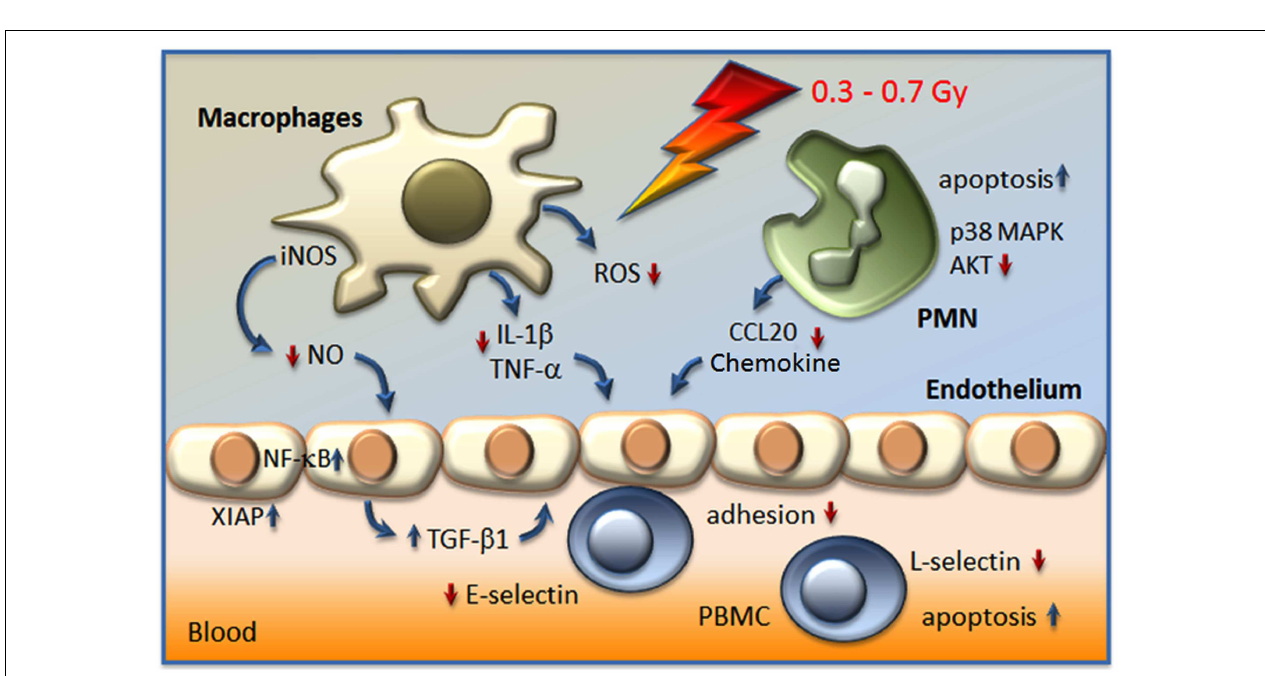
synthase (iNOS) in line with reduced levels of nitric oxide (NO), a lowered production of reactive oxygen species (ROS), and a diminished secretion of interleukin-1 β (IL-1 β ) and tumor necrosis factor- α (TNF- α ) may contribute to local anti-inflammatory effects. Moreover, polymorphonuclear cells (PMN) respond to low-dose exposure with a locally increased rate of apoptosis, a hampered secretion of CCL20 chemokine and alterations in signal transduction pathways p38 mitogen activated protein kinase (MAPK) and protein kinase B